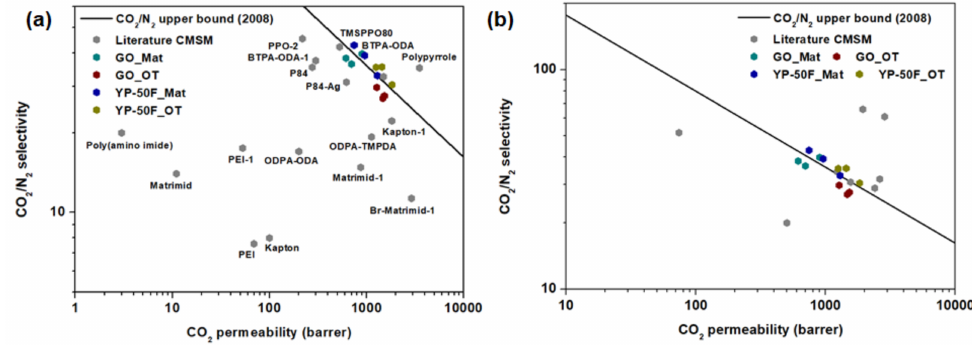
Figure 9. Robeson plot illustrating the performance of the proposed mixed-matrix CMSMs with refer- ence to the literature data for (a) CMSMs [41–50] and (b) mixed-matrix CMSMs [51–53] (summarized in Table S3 and S4,